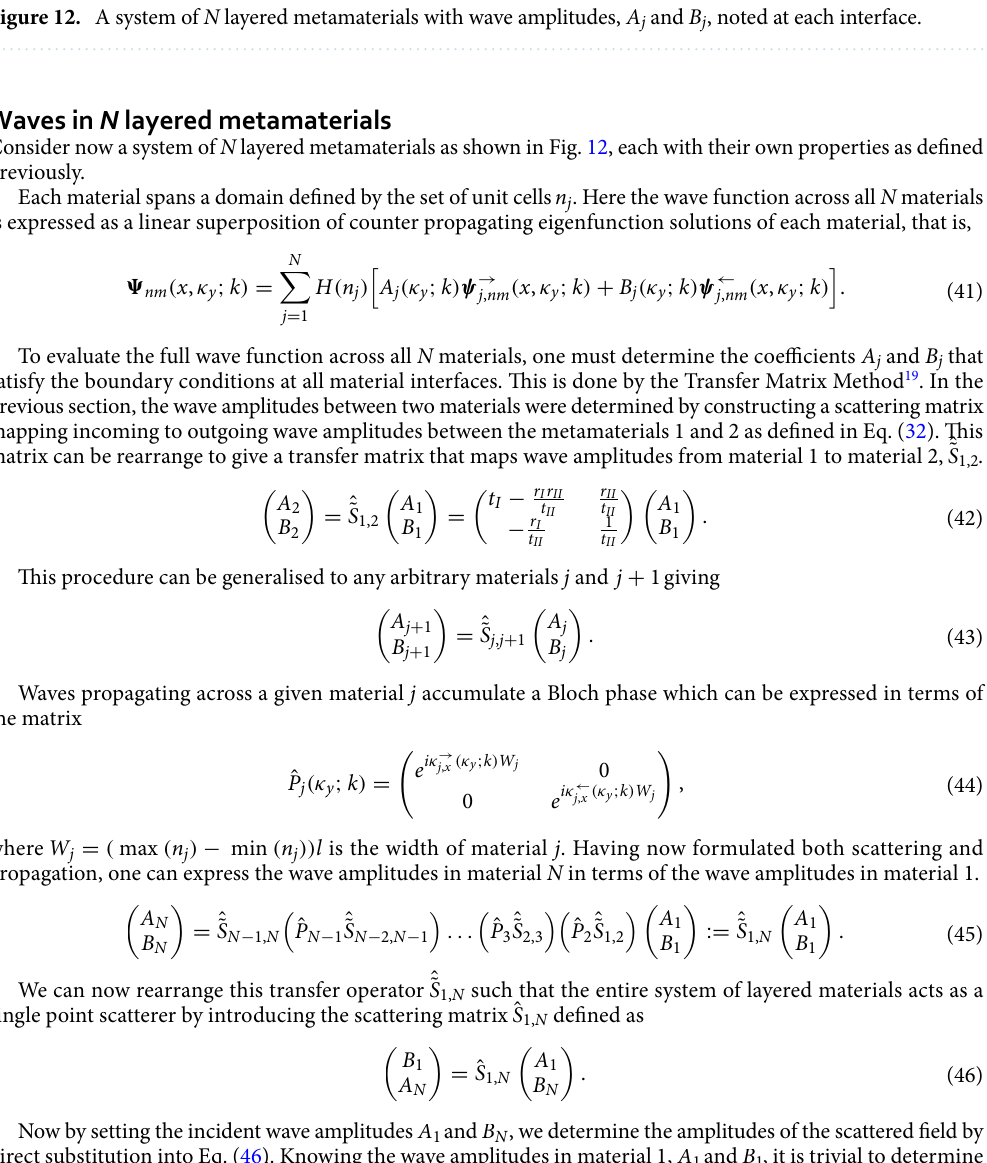
Figure 12. A system of N layered metamaterials with wave amplitudes, A j and B j , noted at each